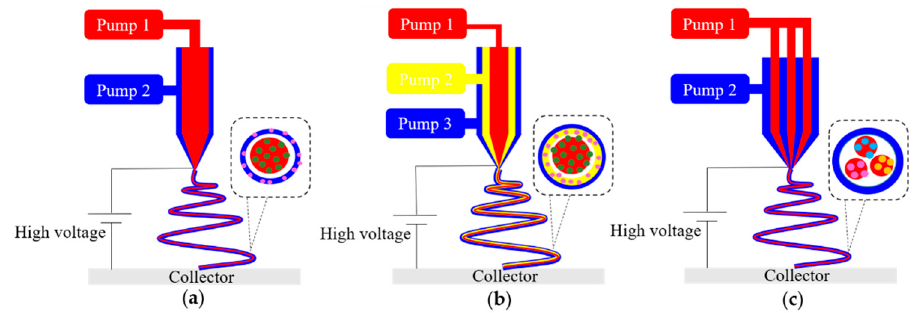
Schematic drawings of multiaxial electrospinning device for fabricating various components for encapsulating multiple drugs. ( a ) Coaxial electrospinning, ( b ) triaxial electrospinning, ( c ) islands-in-the-sea electrospinning.